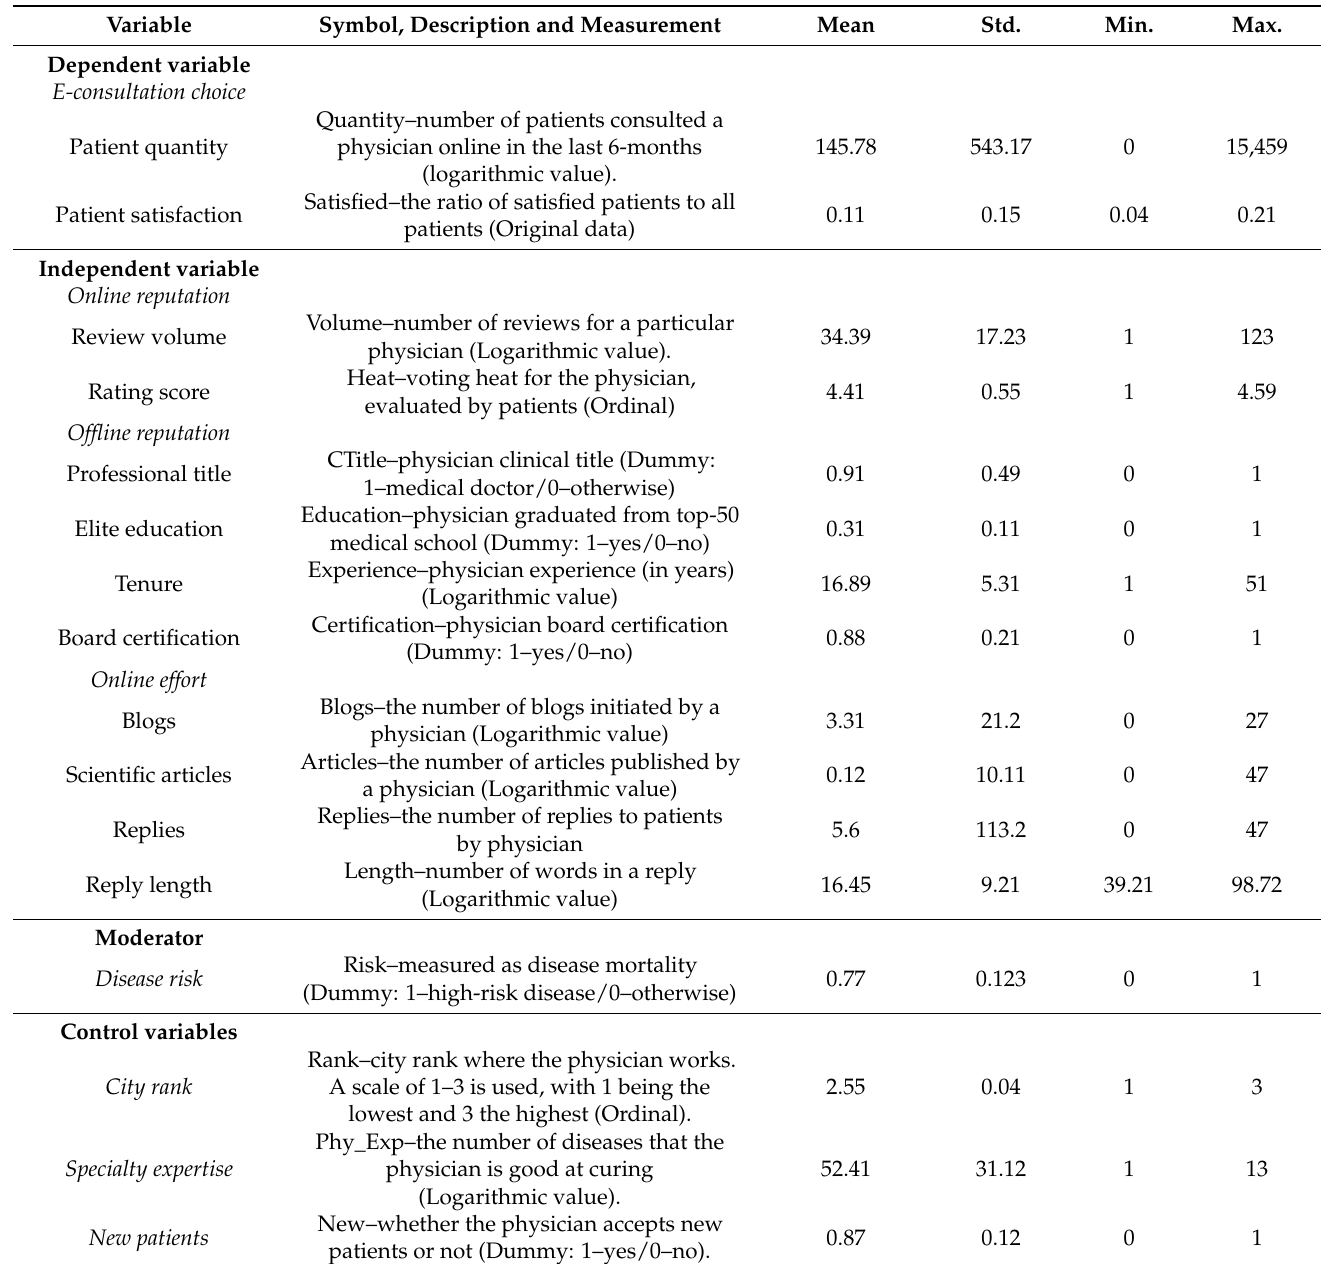
Table 1. Variables’